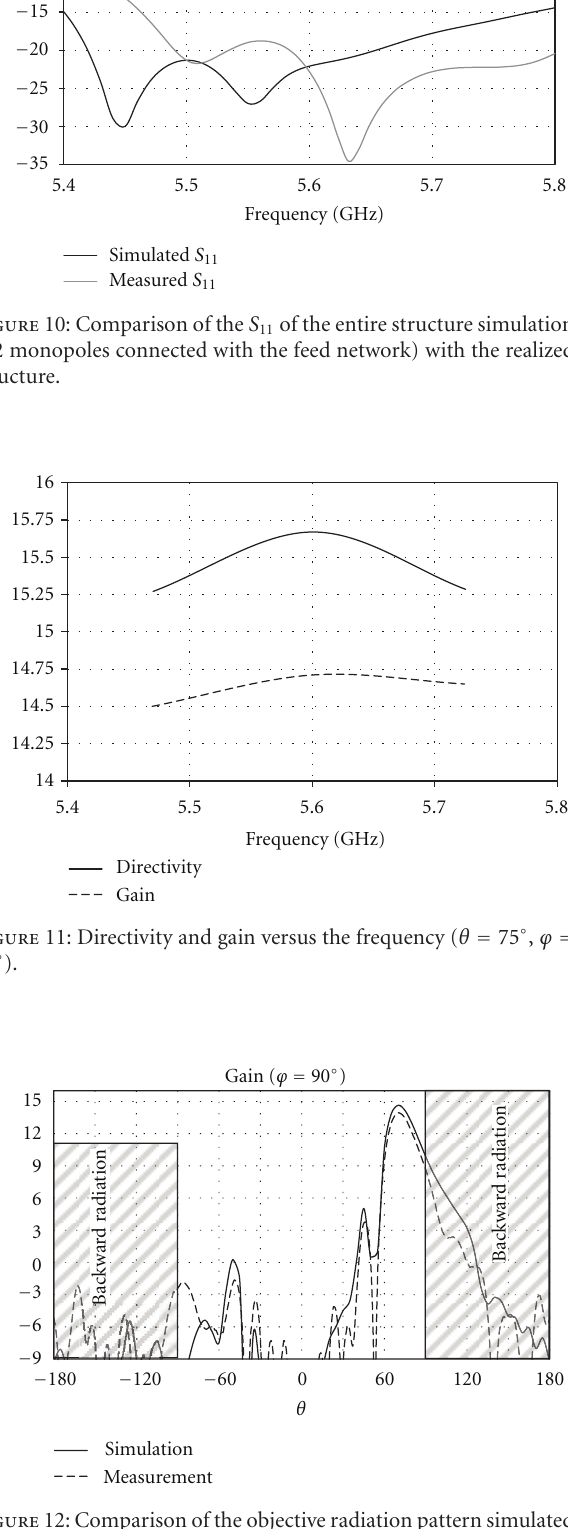
Figure 12: Comparison of the objective radiation pattern simulated with the radiation pattern measured at f = 5 . 6GHz.